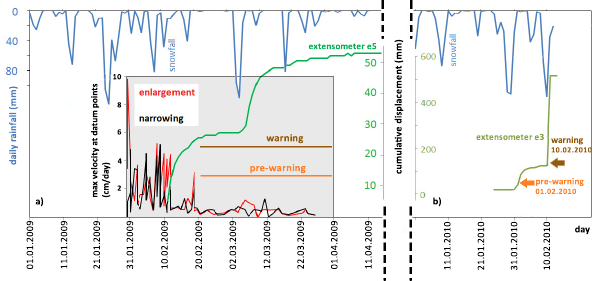
Fig. 4. Rainfalls and superficial displacements recorded at exten- someters and datum points, during the 2009 (a) and 2010 (b) phases of mobilization. Key: (in blue) daily rain; (in black/red): maximum daily displacement rates at datum points; in green) cumulated dis- placements at the extensometers e 5 and e 3 . The empirical, punctual velocity thresholds (3 and 5cm/d), that were employed for manag- ing the emergency, are also shown (after Iovine et al., 2009). Timing of pre-warning and warning conditions is